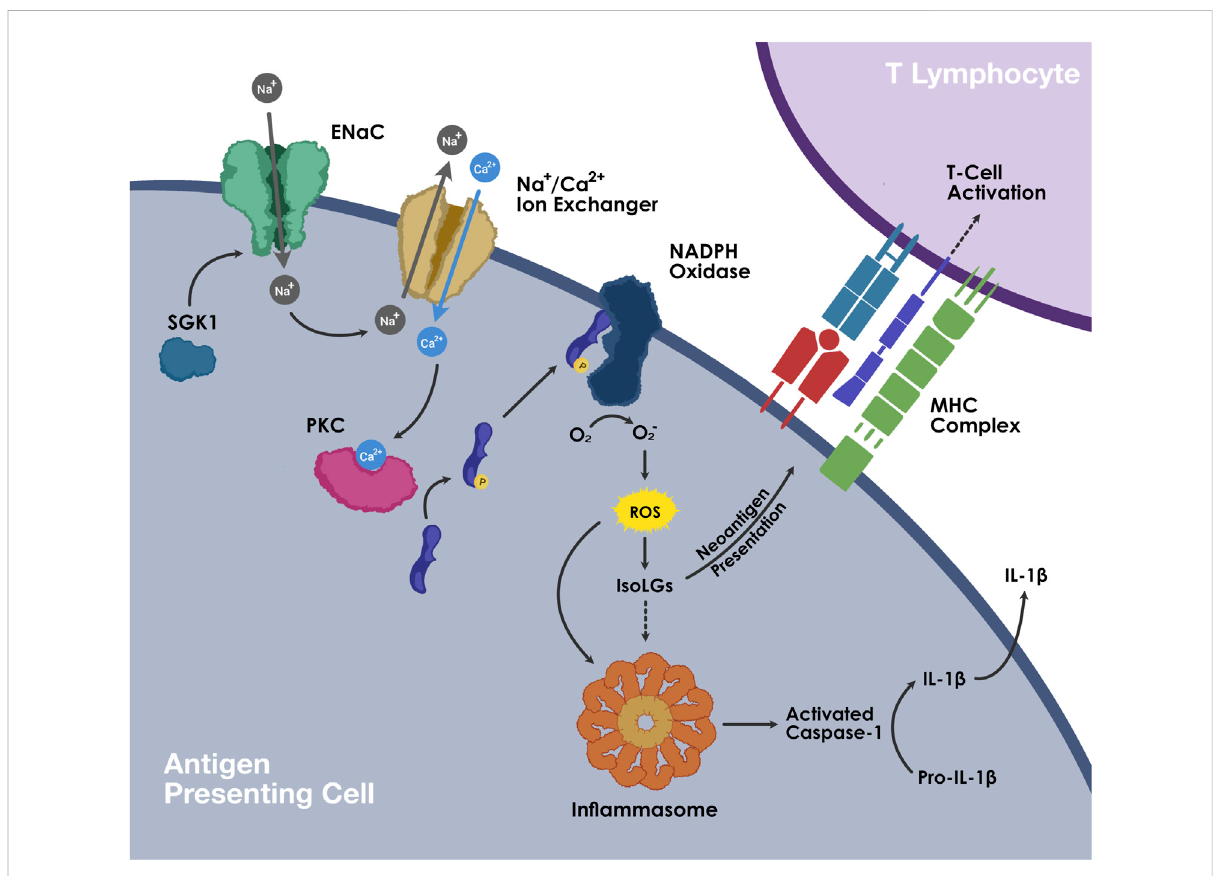
The mechanism of ENaC and IsoLG-dependent NLRP3 in fl ammasome activation in